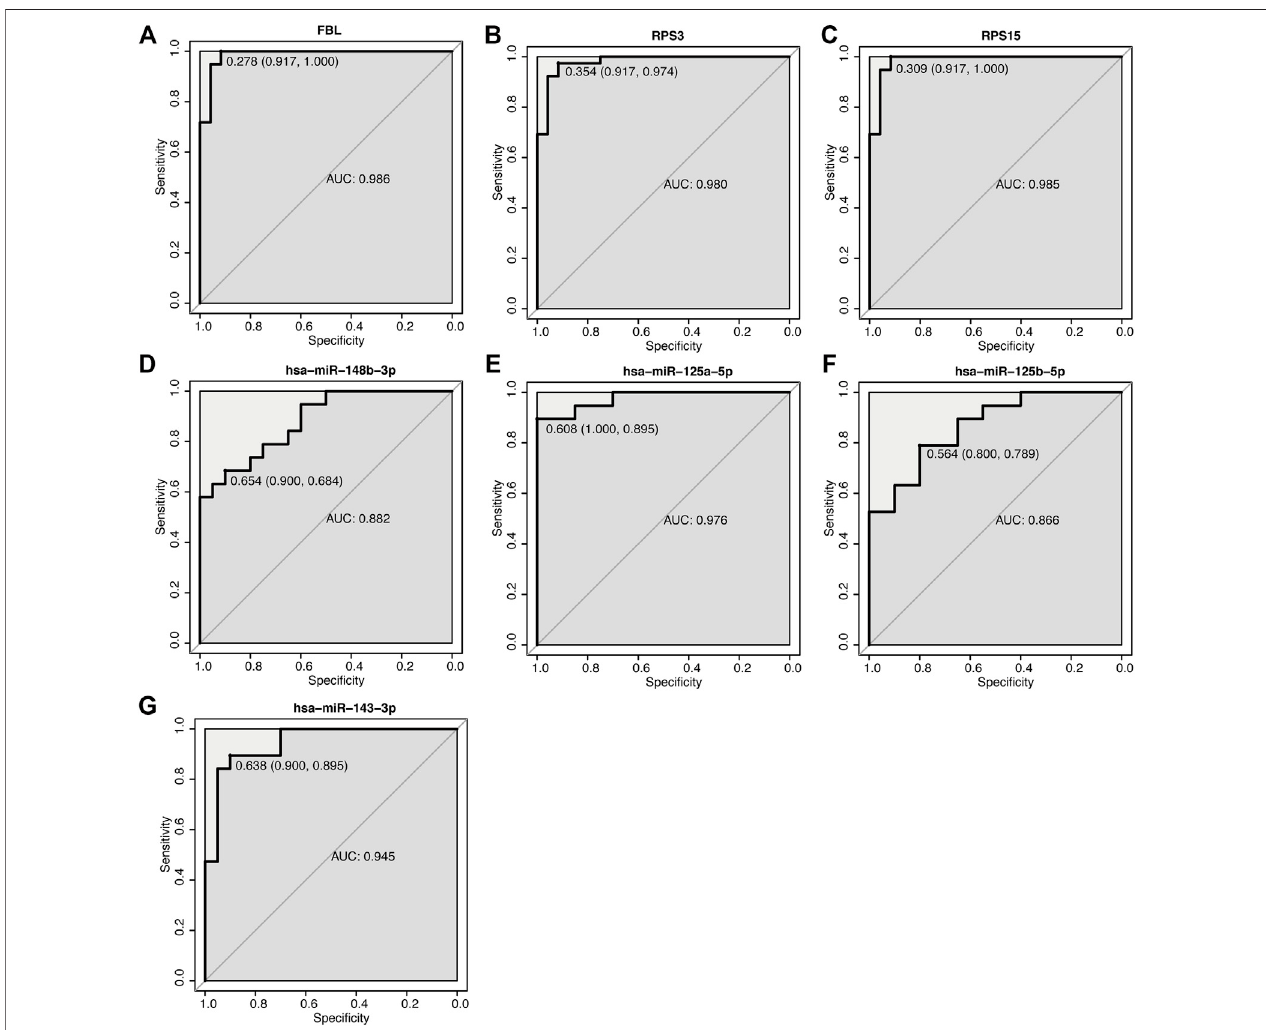
FIGURE 10 | ROC curve of key mRNA and miRNA. (A – G) ROC curve of mRNA and miRNA. The abscissa is speci fi city, and the ordinate is sensitivity (true positive rate), speci fi city = 1 (false positive rate) AUC is the area under the ROC curve enclosed by the coordinate axis.